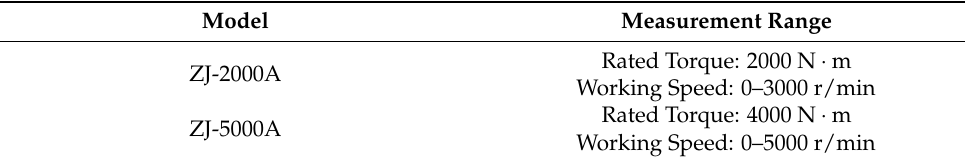
Figure 2. Test bench of ‘variable-pump and constant-motor’ system. Note: ① Engine (DEUTZ TCD2013L062V); ② Gear box combined by the ‘variable-pump and constant-motor’ system; ③ Speed torque sensor of ZJ-5000A model; ④ Auxiliary gearbox; ⑤ Electrical eddy current dynamometer of DW250 model; ⑥ Hydraulic system (realizing lubrication, cooling, and other functions). The test bench uses the speed torque sensors of the ZJ-2000A model and ZJ-5000A model of Lanling Jiangsu, China. Table 1 gives the ranges of speed and torque. Table 1. Related parameters of motor.